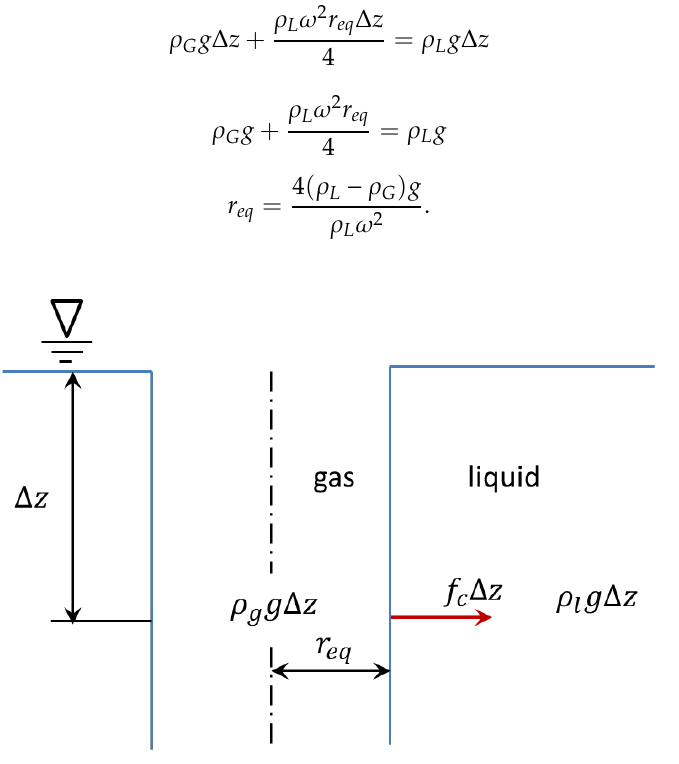
Figure 2. Pressure balance for a stable gas core.